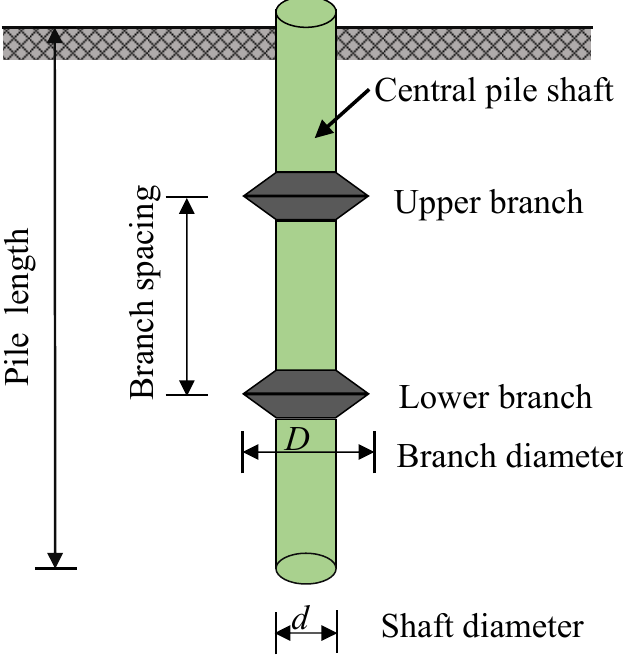
Figure 8. Schematic diagram of the squeezed branch pile.